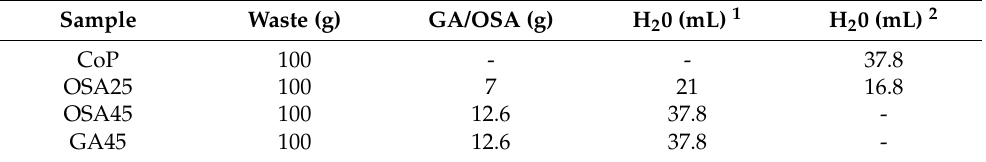
Table 1. Orange juice co-product formulations without biopolymers added (CoP) or with 0.25 g